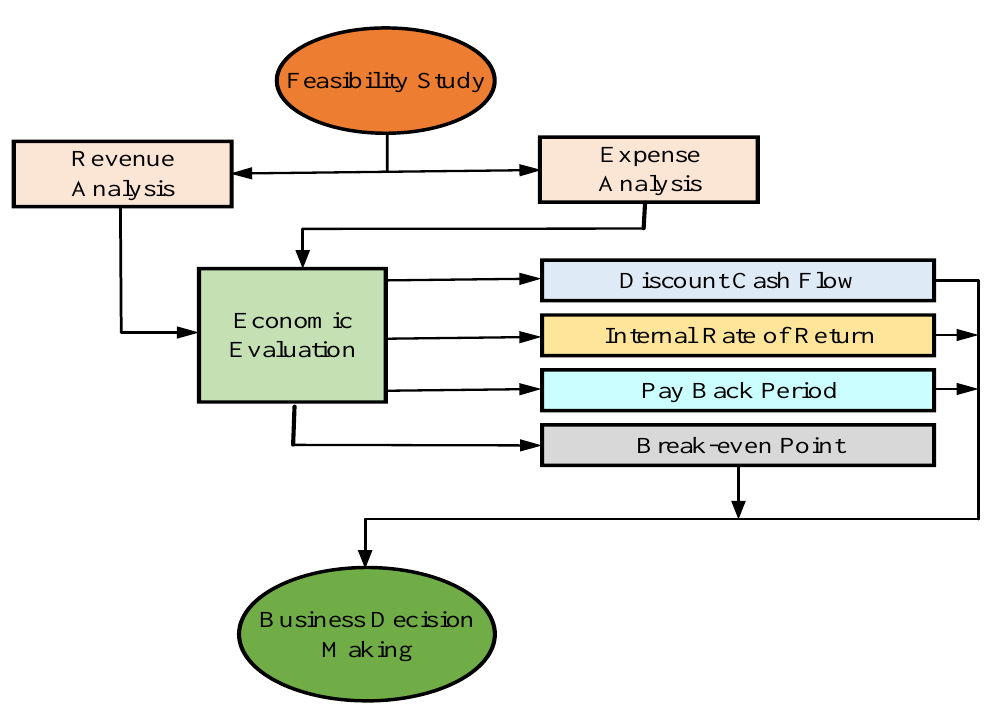
Figure 8. The general procedure of business decision making.